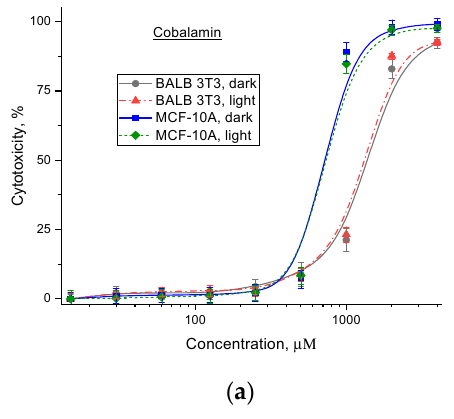
Figure 3. Dark and photo-cytotoxicity curves of cobalamin (Cbl) studied on: ( a ) normal BALB 3T3 cell line and non-tumorigenic MCF-10A cell lines; and ( b ) MCF-7 and MDA-MB-231 tumor cell lines. Non-peripherally substituted 3ZnPc was evaluated as a more powerful photosensi- tizer in comparison to peripherally substituted 4ZnPc for the tested tumor cell lines. The presented curves for 3ZnPc on tumor cell and the non-tumorigenic cells showed а con- centration gap between the samples with and without irradiation for both of the tested ZnPcs (Figure 4).